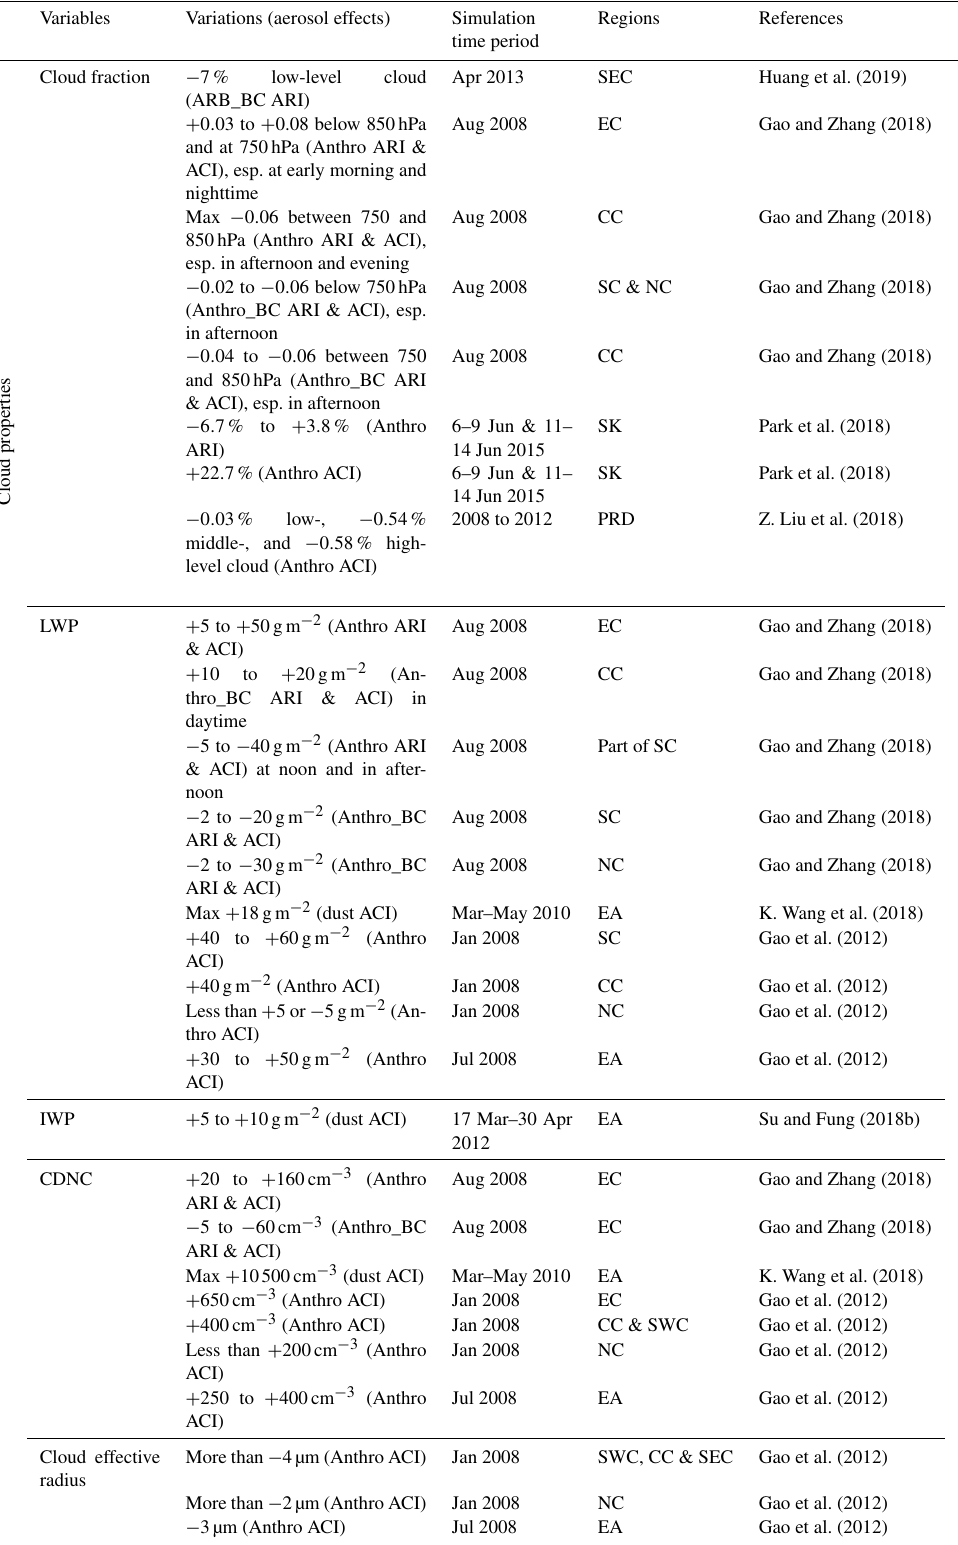
Table 7. Summary of changes in cloud properties and precipitation characteristics due to aerosol feedbacks simulated by two-way coupled models (WRF-Chem, WRF-CMAQ, GRAPES-CUACE, WRF-NAQPMS, and GATOR-GCMOM) in